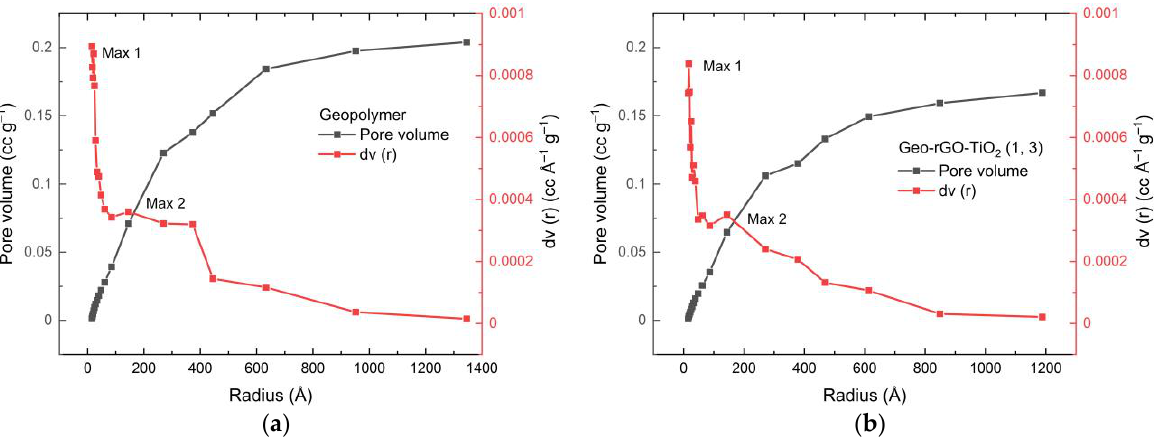
Figure 14. Pore distribution calculated by using BJH (Barrett–Joyner–Halenda) method for ( a ) geopolymer; ( b ) Geo–rGO– TiO 2 (1, 3). Table 5. BET parameters for pervaporation membrane samples.